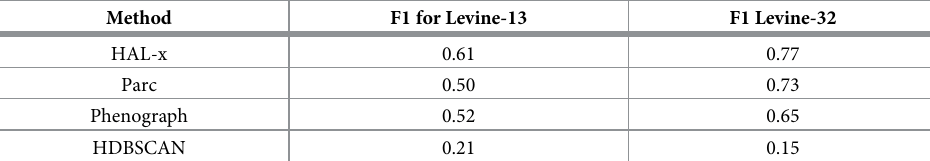
Table 1. F1 Measure of clustering accuracy for diverse methods, applied onto CyTOF datasets from